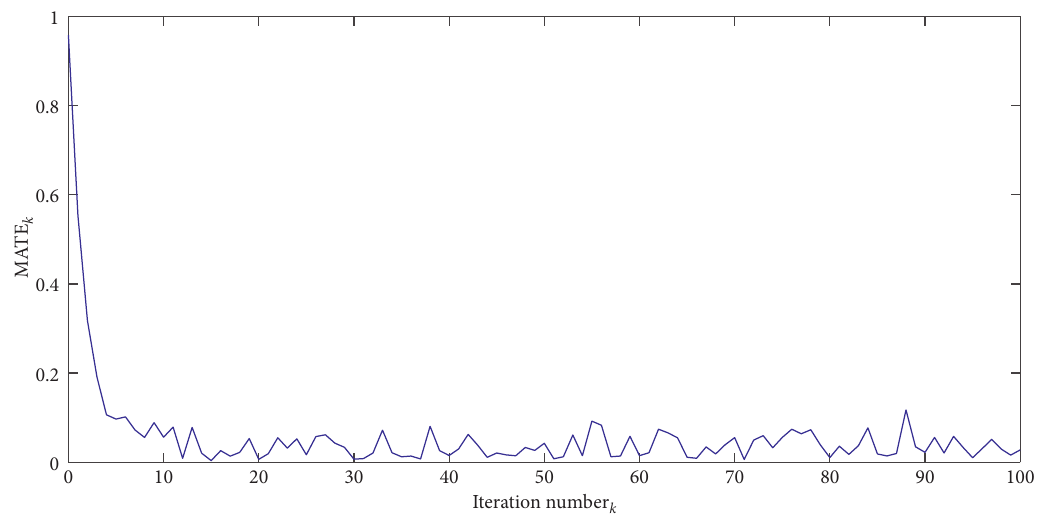
( n , n ) for n ∈ 0 , 1 , ... , 20 { } and n d 1 2 1